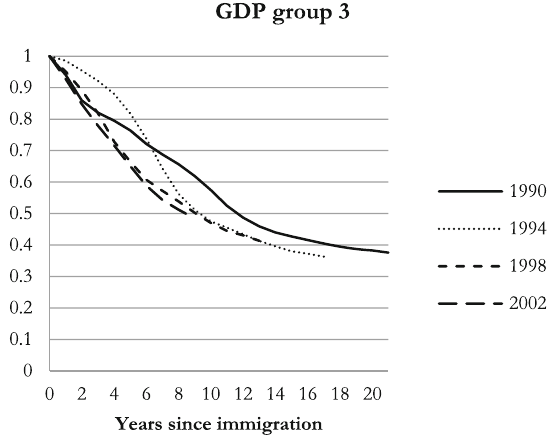
Figure 6 is presented incorrectly in the published article. The corrected presentation of Fig. 6